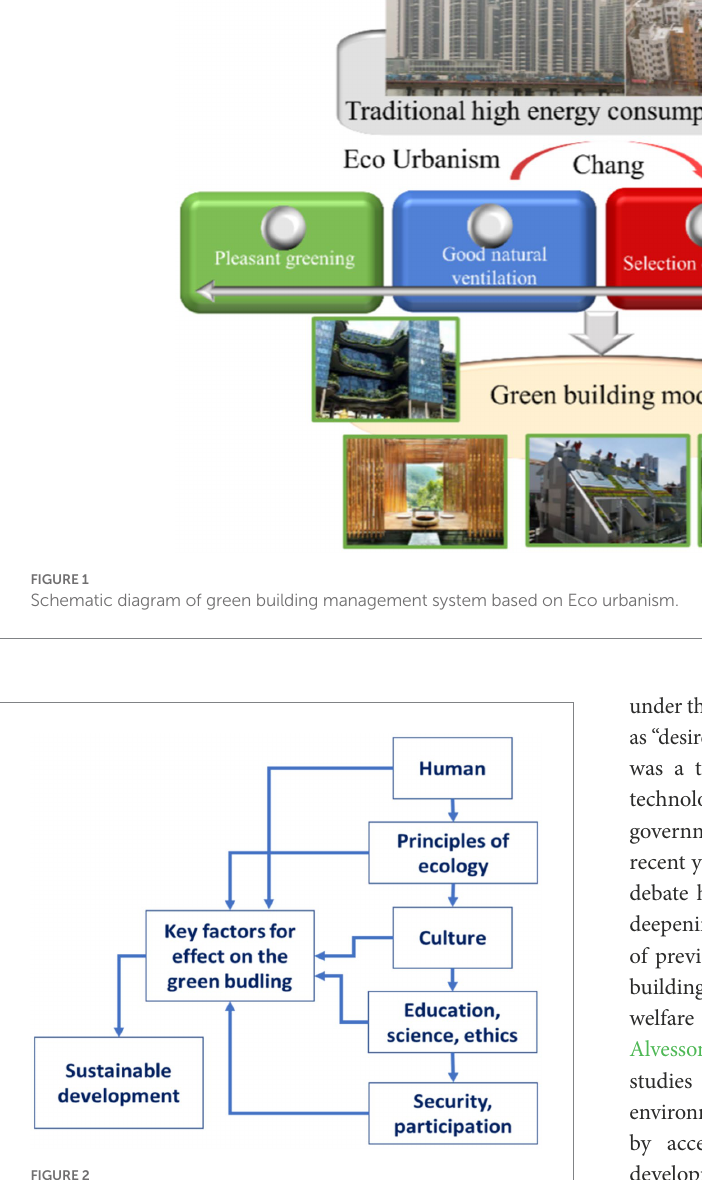
FIGURE 2 The relationship between green building and sustainable development